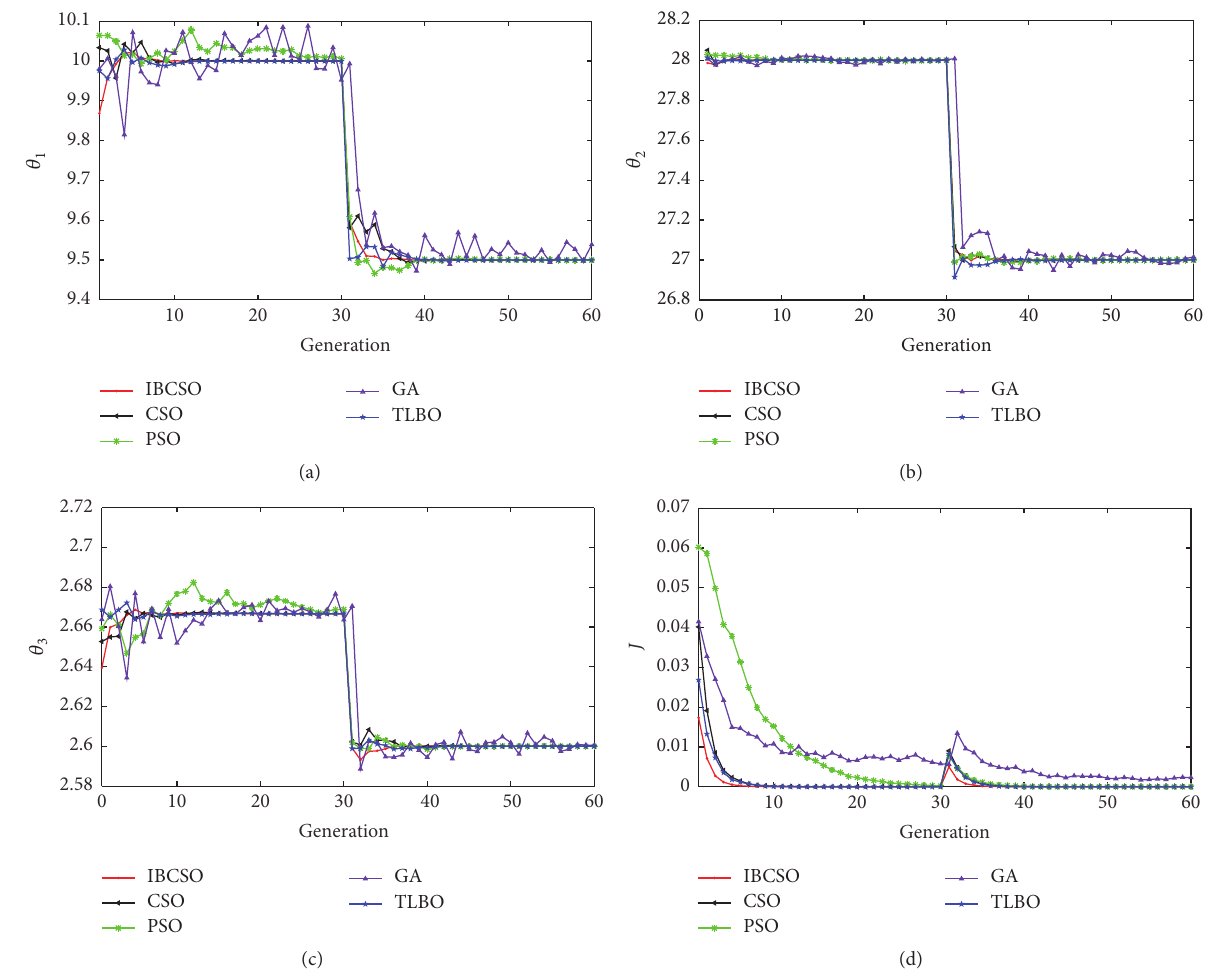
Figure 4: The evolving process of the average values obtained by IBCSO, CSO, PSO, GA, and TLBO in online mode. (a) 𝜃 1 ; (b) 𝜃 2 ; (c) 𝜃 3 ; (d) 𝐽 .